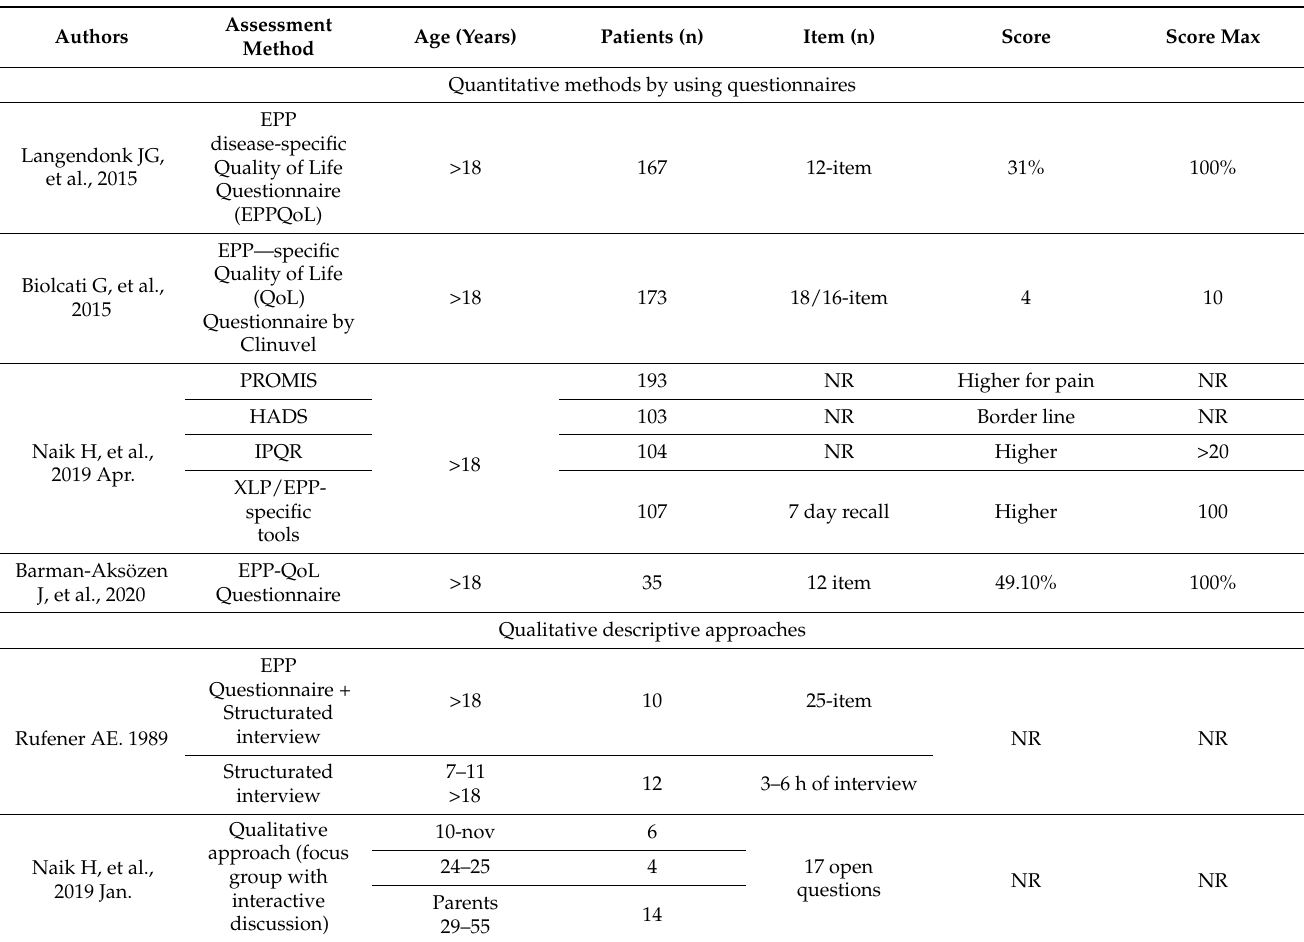
Table 3. The sum-up of the literature of AHPs: author of publications; methodology approach used for the psychological or QoL assessment; age; number of screened patients; number of the item; field; significative score; the maximum score. NR = not